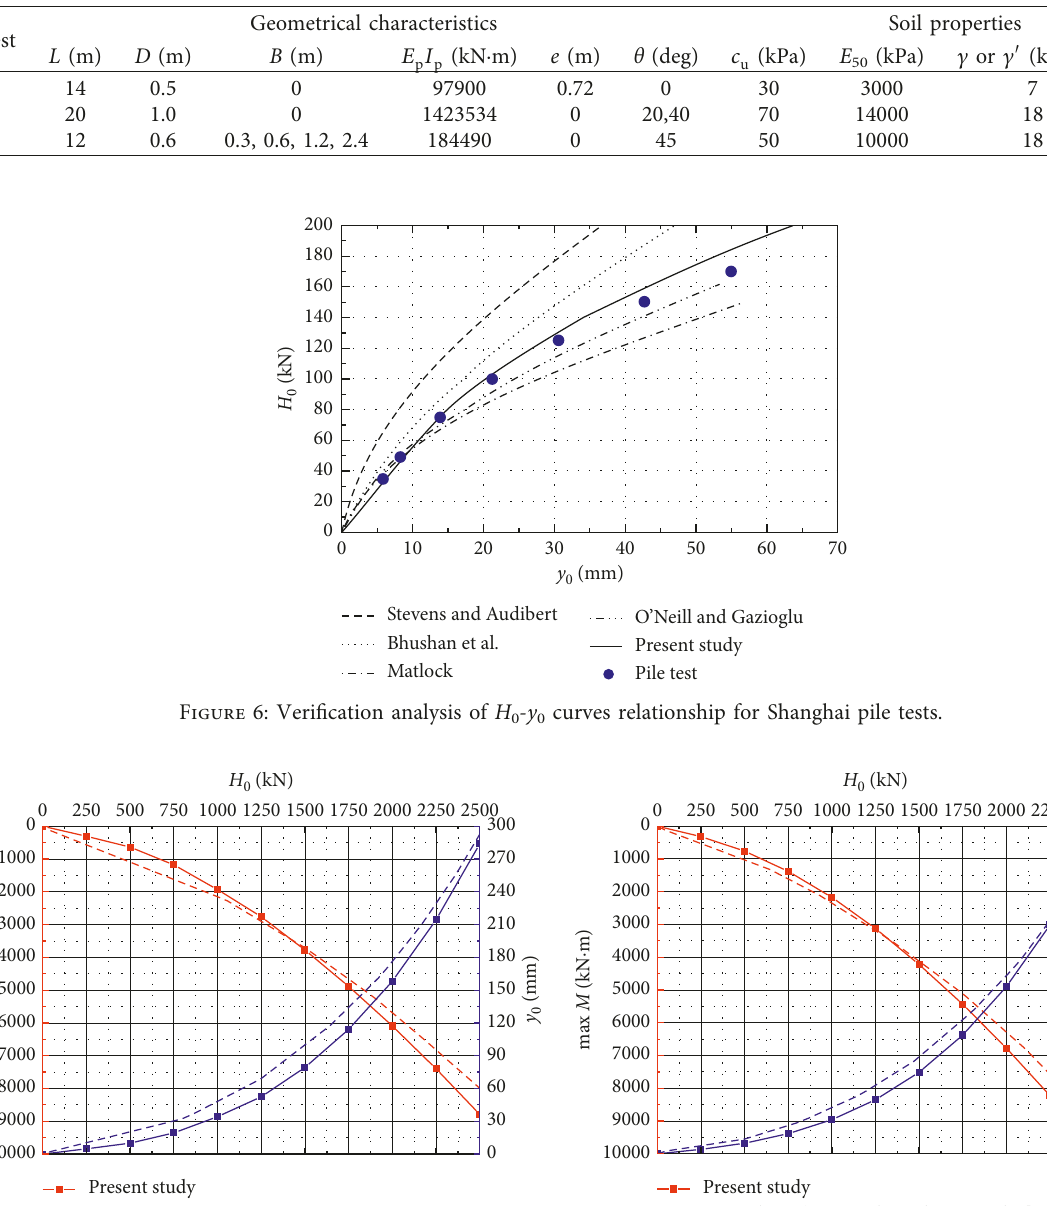
Table 1: Summary of pile load test.